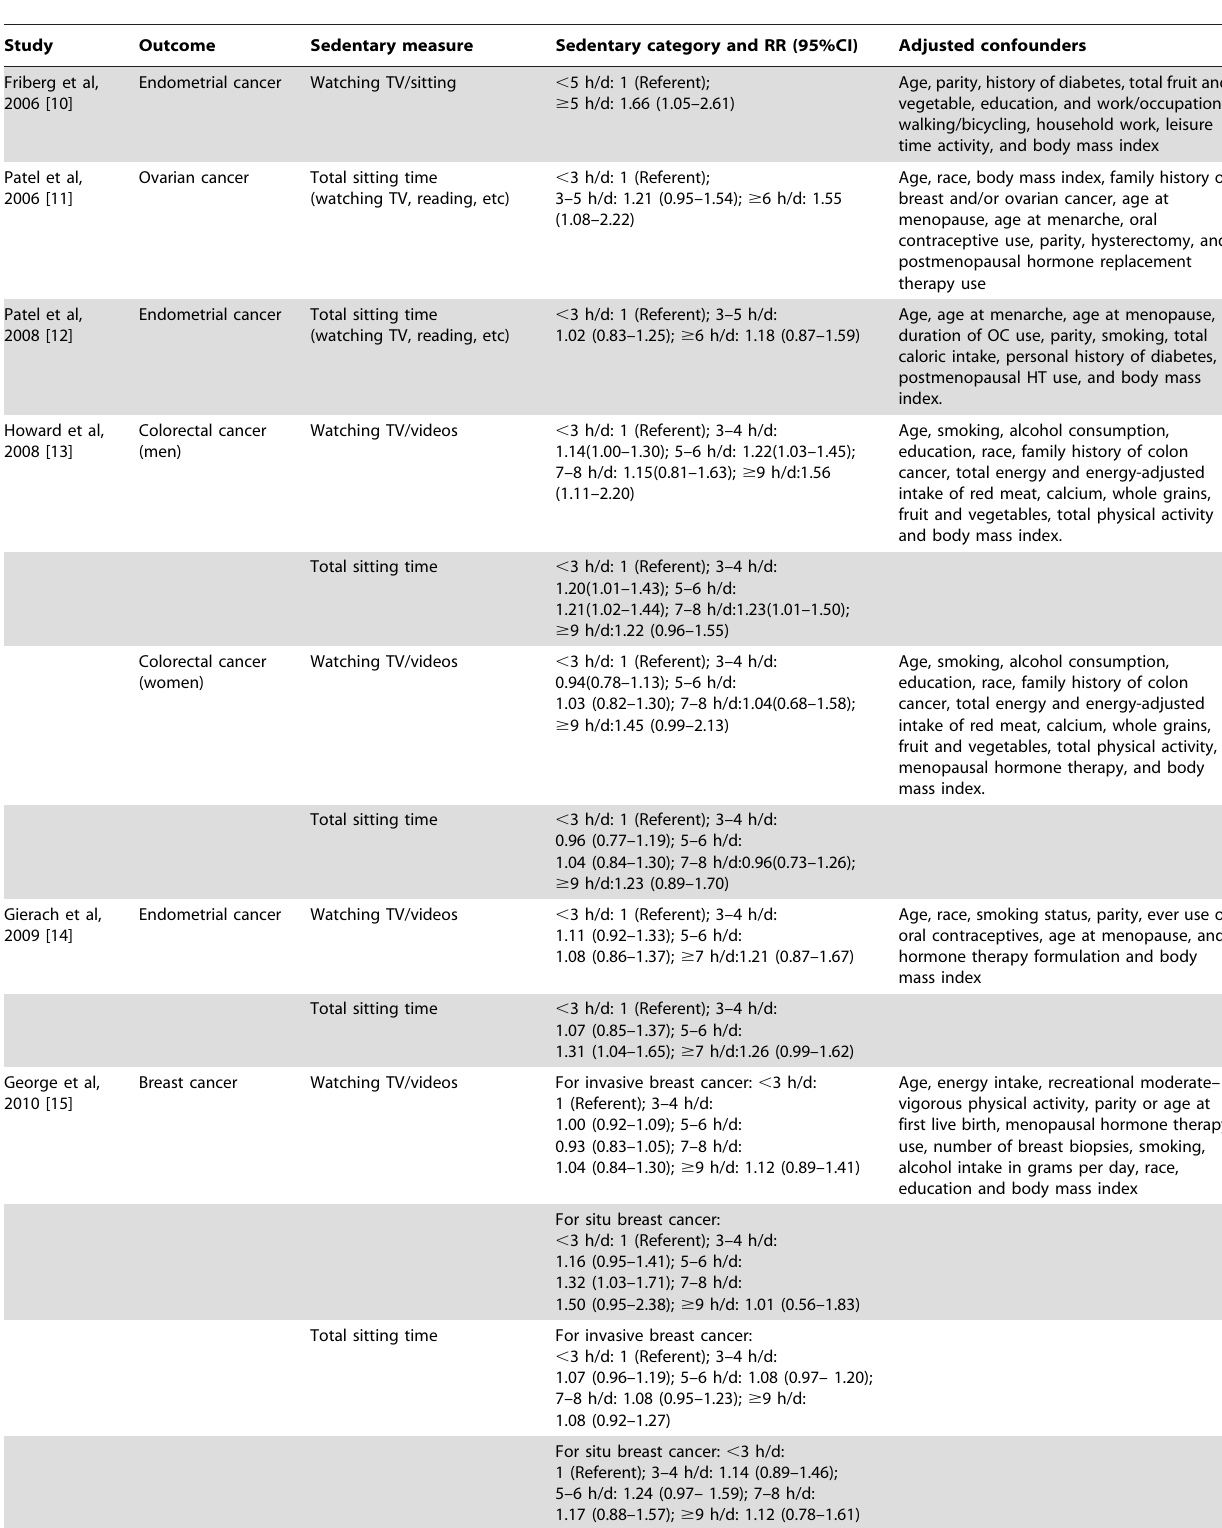
Table 2. RRs and 95%CIs reported by included prospective studies examining the association between sedentary behavior and incident